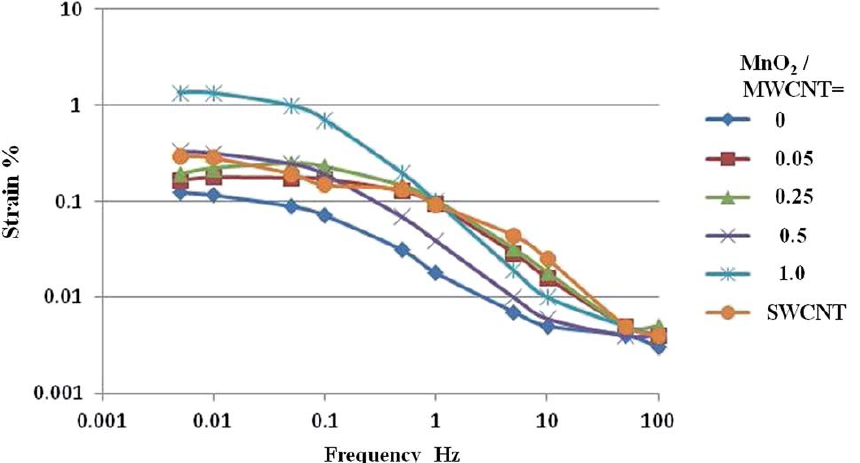
Figure 3. Actuator stretching, recalculated from the peak-to-peak displacement of the actuator with the gel electrode of “polymer/CNT/EMIM[CF 3 SO 3 ]” and different concentrations of MnO 2 in relation to CNTs (sets of points MnO 2 /MWCNT = 0, MnO 2 /MWCNT = 1 are selected). Reproduced from [26] with permission from the Royal Society of Chemistry. Copyright 2016.